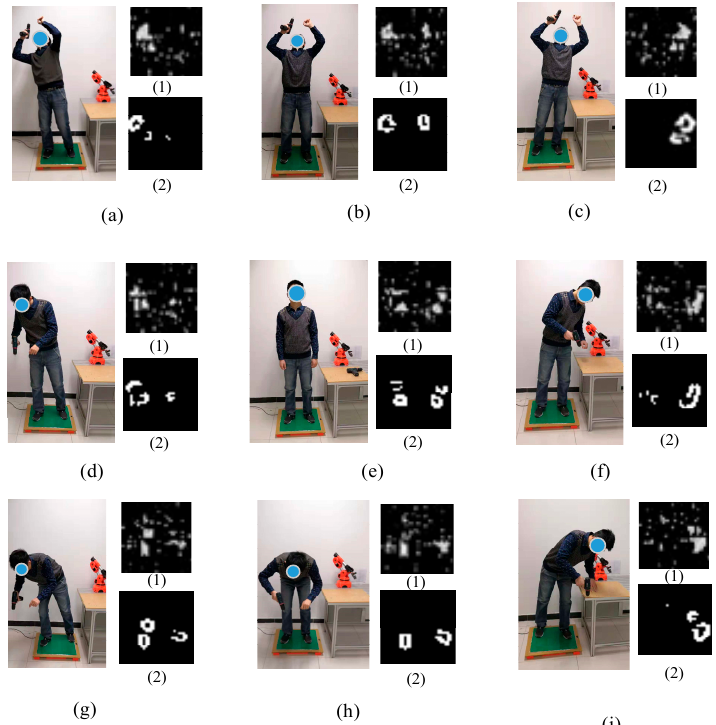
Figure 6. Standing postures evaluated in the experiment: ( a ) RBS; ( b ) BIS; ( c ) LBS; ( d ) RLS; ( e ) URS; ( f ) LLS; ( g ) RFS; ( h ) FLS; and ( i ) LFS. In each case, ( 1 ) is the original image and ( 2 ) is the image after Gaussian filtering.